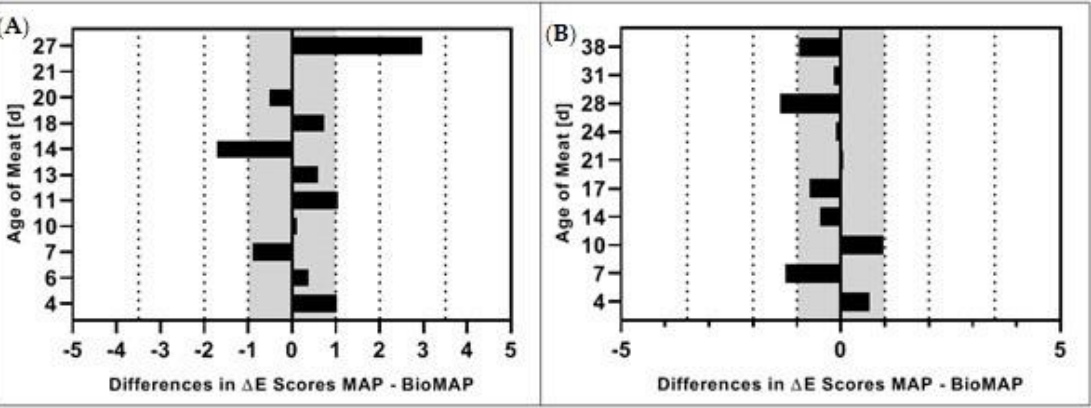
Figure 7. Differences in ∆E in MAP and BioMAP in ( A ) ground pork (GM) and ( B ) pork loin (PL) over meat ages of 27 and 38 days, respectively. The dotted lines indicate color ranges as described in Table 2, while the the gray areas indicate the range where no difference is noticeable.